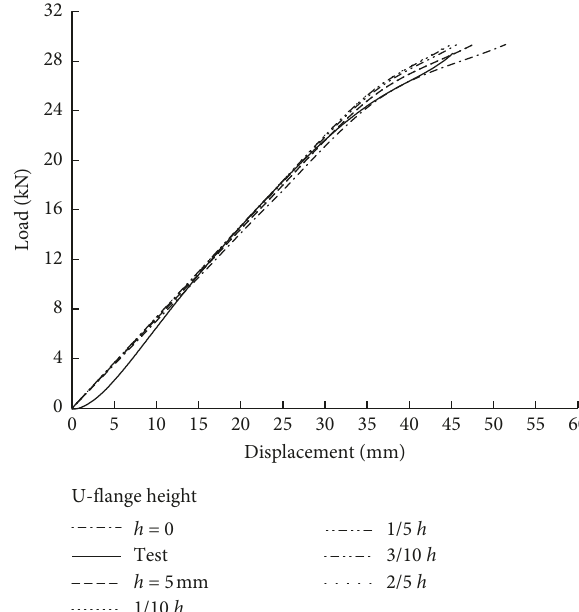
Figure 7: AU-T load-displacement